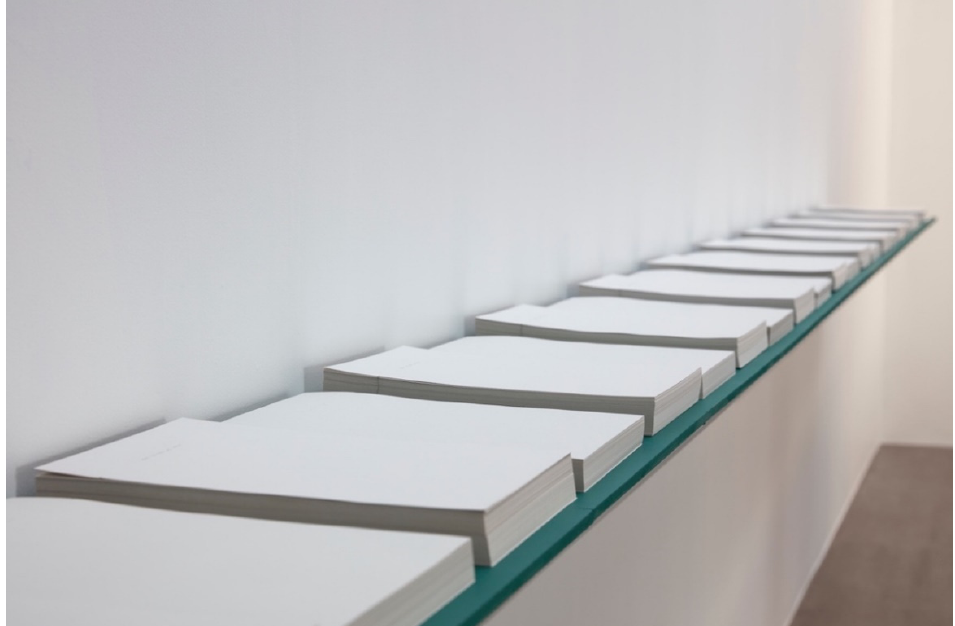
Figure 1. The days we’ve been together , 2018. Te Uru Wait ā kere Contemporary Gallery, Titirangi, T ā maki Makaurau Installation detail of Blind Carbon Copy: An Open Love Letter , curated by Ioana Gordon-Smith. Typewriter marks on paper, dimensions variable. Collection of the artist. Photo: Sam Hartnett.